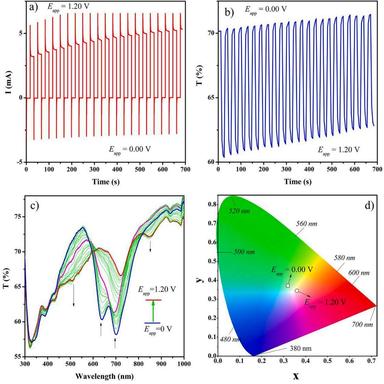
Electrochromism of the ITO/ LuPc2/Nf film in DCM/TBAP electrolyte. (a) Current-time responses recorded with 20 CC cycles between applied potentials of 0.0 V and 1.20 V. (b) %T time responses obtained with cycles of 20 rCA between 0.0 V and 1.20 V. (c) In situ %T versus time changes during CA excitation at 1.20 V. (d) Chromaticity diagram showing the colors of the film at the applied potentials of (□) 0.0 V and (○) 1.20 V.